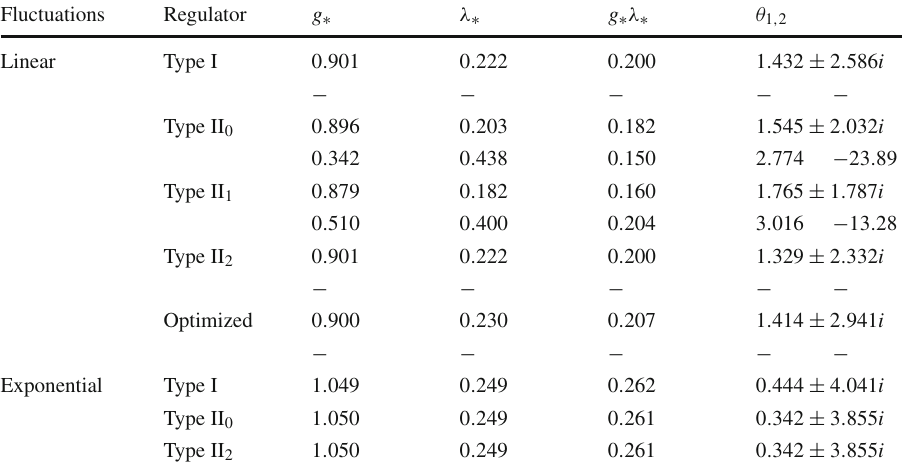
Fluctuations Regulator g ∗